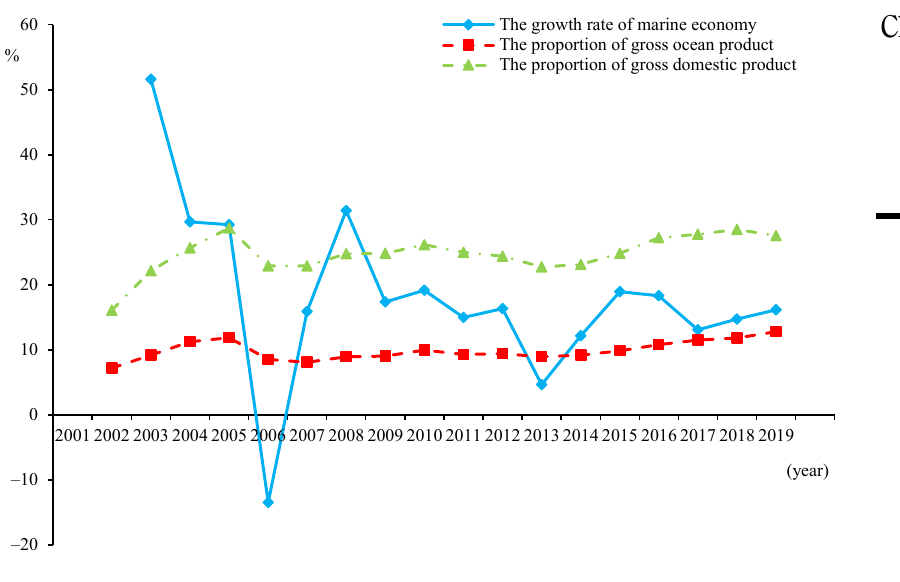
Figure 7. The development of